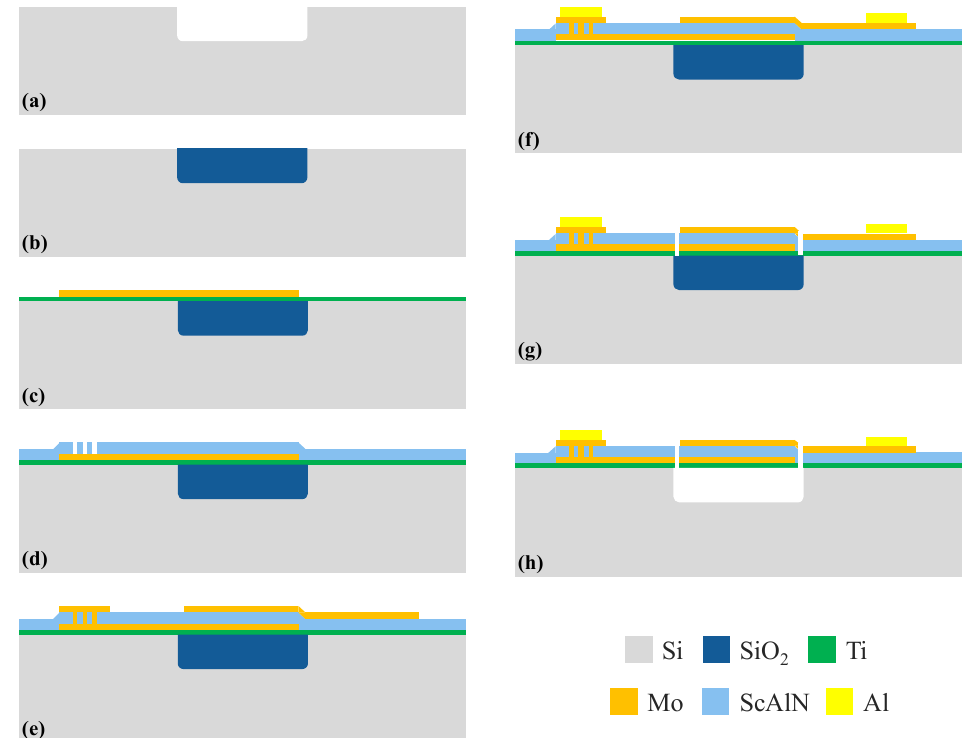
Figure 3. ScAlN FBAR fabrication process flow diagram: ( a ) Etching swimming pool on high-resistance silicon. ( b ) Deposit SiO 2 and CMP. ( c ) Deposit Ti and Mo, pattern. ( d ) Deposit ScAlN, pattern. ( e ) Deposit Mo, pattern. ( f ) Deposit Al pad, pattern. ( g ) Etch release holes and trench. ( h ) VHF release SiO 2 .